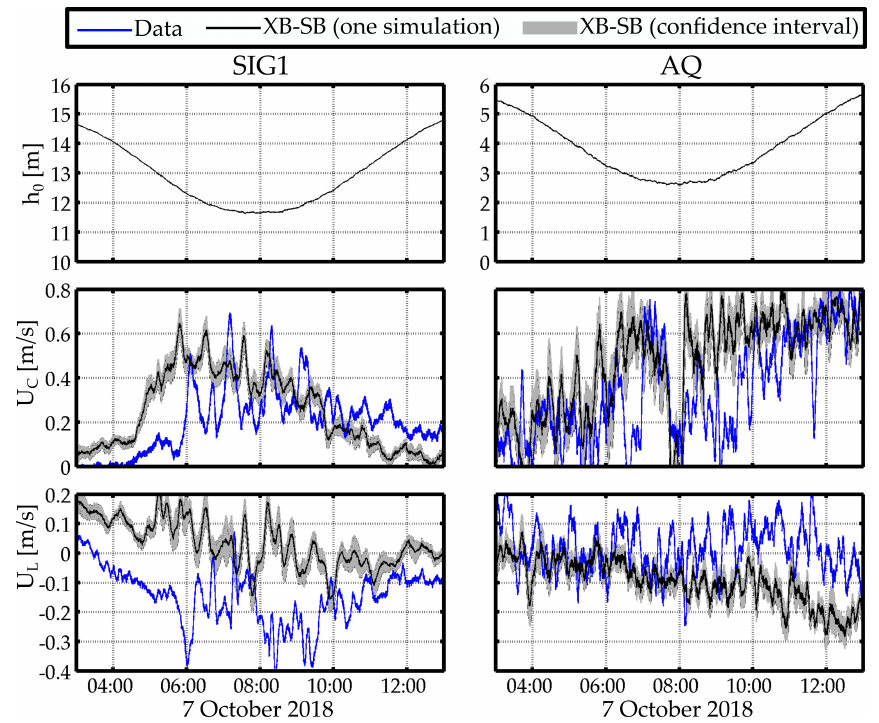
Figure 7. Modelled mean water depth ( h 0 ; top panels). Modelled (black) and measured (blue) 5 min running-averaged cross-shore ( U c ; middle panels) and longshore velocities ( U L ; bottom panels) for event D2 at SIG1 and AQ locations. Note that measurements at SIG2 and SIG3 were not available at this time. Black line and grey area show the modelled velocities of one simulation and the confidence interval computed from ten simulations (see Section 2.3).